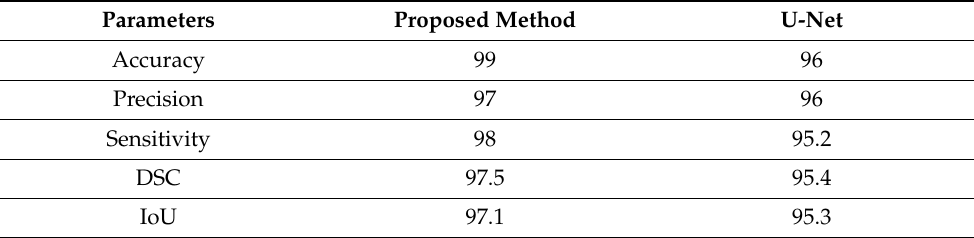
Table 4. Evaluation Analysis of the Proposed and benchmark